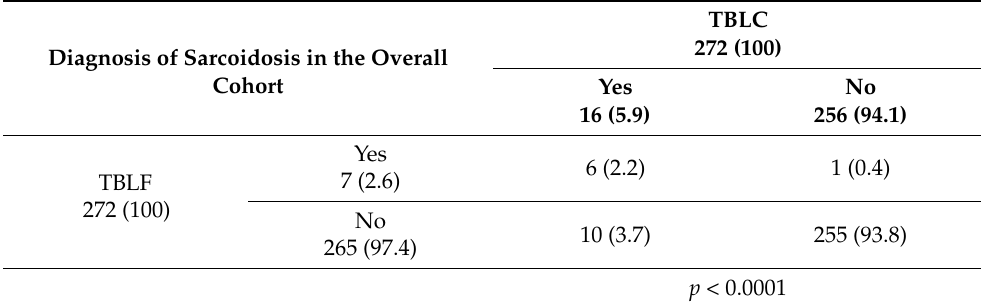
Diagnosis of Sarcoidosis in the